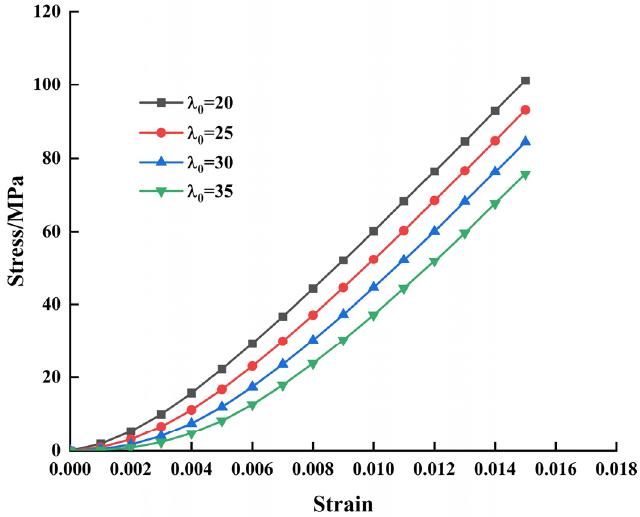
λ study. Figure 14. Parameter λ 0